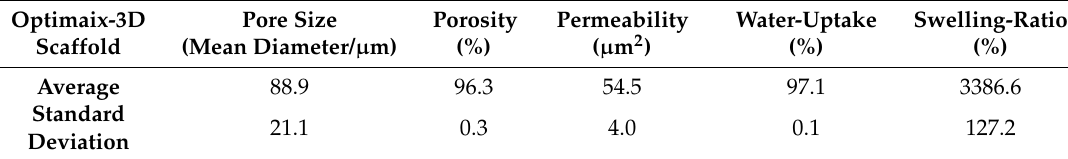
Table 2. Characteristics of Optimaix-3D